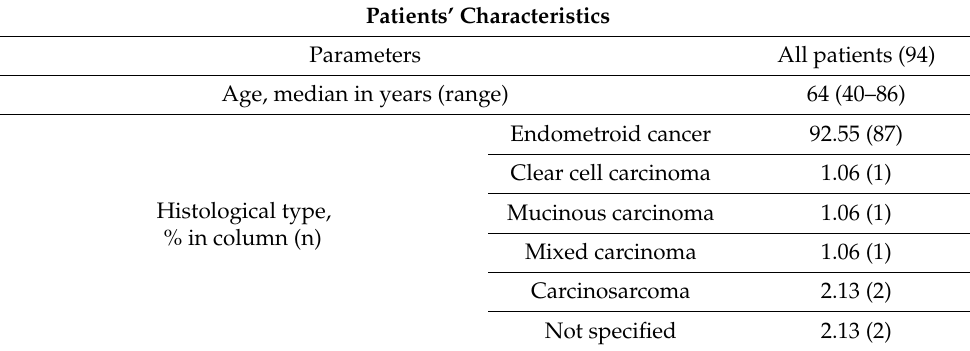
Table 1. Patient characteristics. For this study, 94 tissue samples of malignant endometrial neoplasms were collected between 2012 and 2014 from the archives of the Department of Pathomorphology, Jagiellonian University Medical College, Krakow. Pathomorphological examination led to the iden- tification of six different histological types. Clinicopathological features were analyzed only for endometrioid ECs (87 samples) because the number of non-endometrioid cancers was insufficient. Endometrioid carcinomas were graded with a 3-tier system developed by the International Federation of Gynecology and Obstetrics (FIGO) that counts glandular architecture, percentage of non-squamous solid components, and nuclear atypia. Pathologic TNM staging of ECs was performed according to AJCC Cancer Staging Manual, 7th edition, which was valid at the time of diagnosis. The depth of myometrial invasion and cervical stromal, serosal, and adnexal involvement were relevant to the pT category. Data regarding patients’ ages were collected, based on which five age groups were